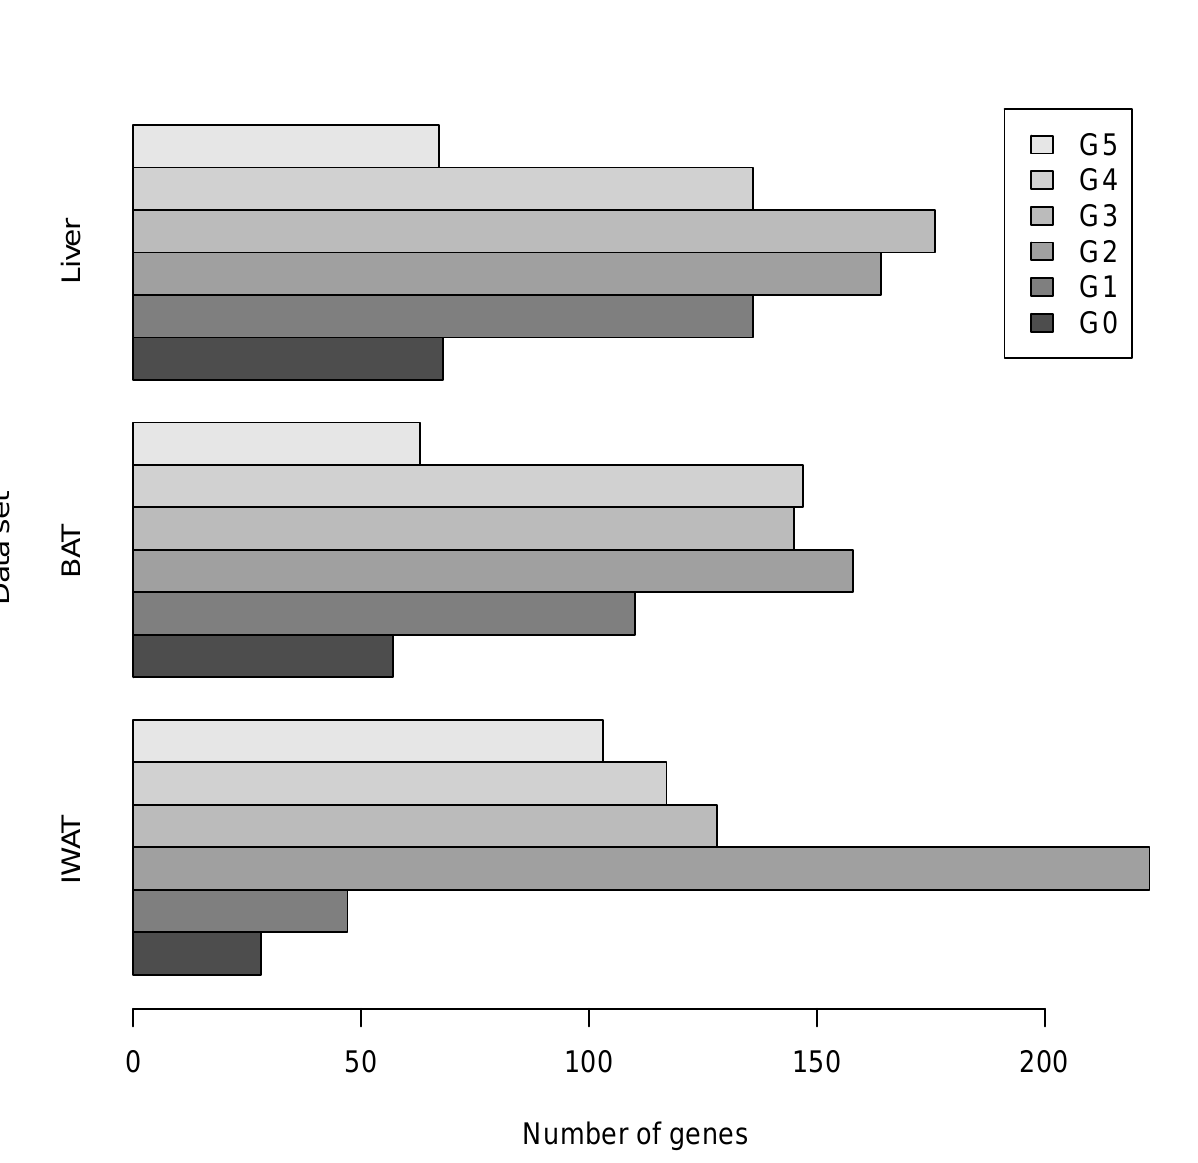
Fig 5. Barplot of the number of genes against phases. Bar plot summarizing the number of genes in each phase for the IWAT, BAT and Liver data sets from the results in Table